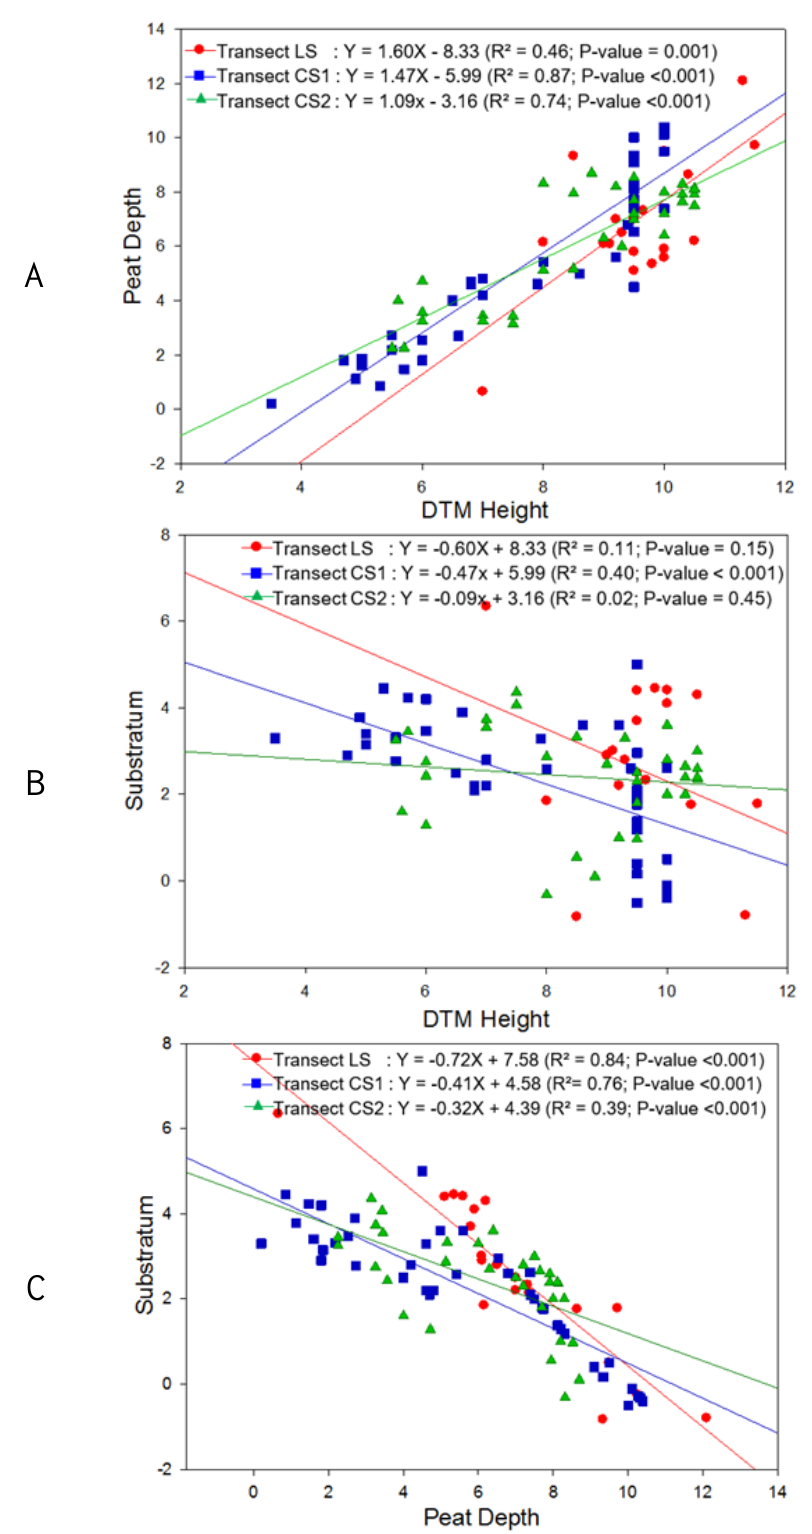
Figure 7. Linear regression relationships between land surface altitude (DTM height), peat thickness (= peat depth) and substratum altitude. All relationships between DTM height and peat depth (Panel A), and between substratum altitude and peat depth (Panel C) are significant (P-value < 0.05), but there is no significant relationship (P-value > 0.05) between DTM height and substratum altitude (Panel B) in Transects LS and CS2. Number of observations (n) is 21 for Transect LS, 40 for Transect CS1 and 33 for Transect